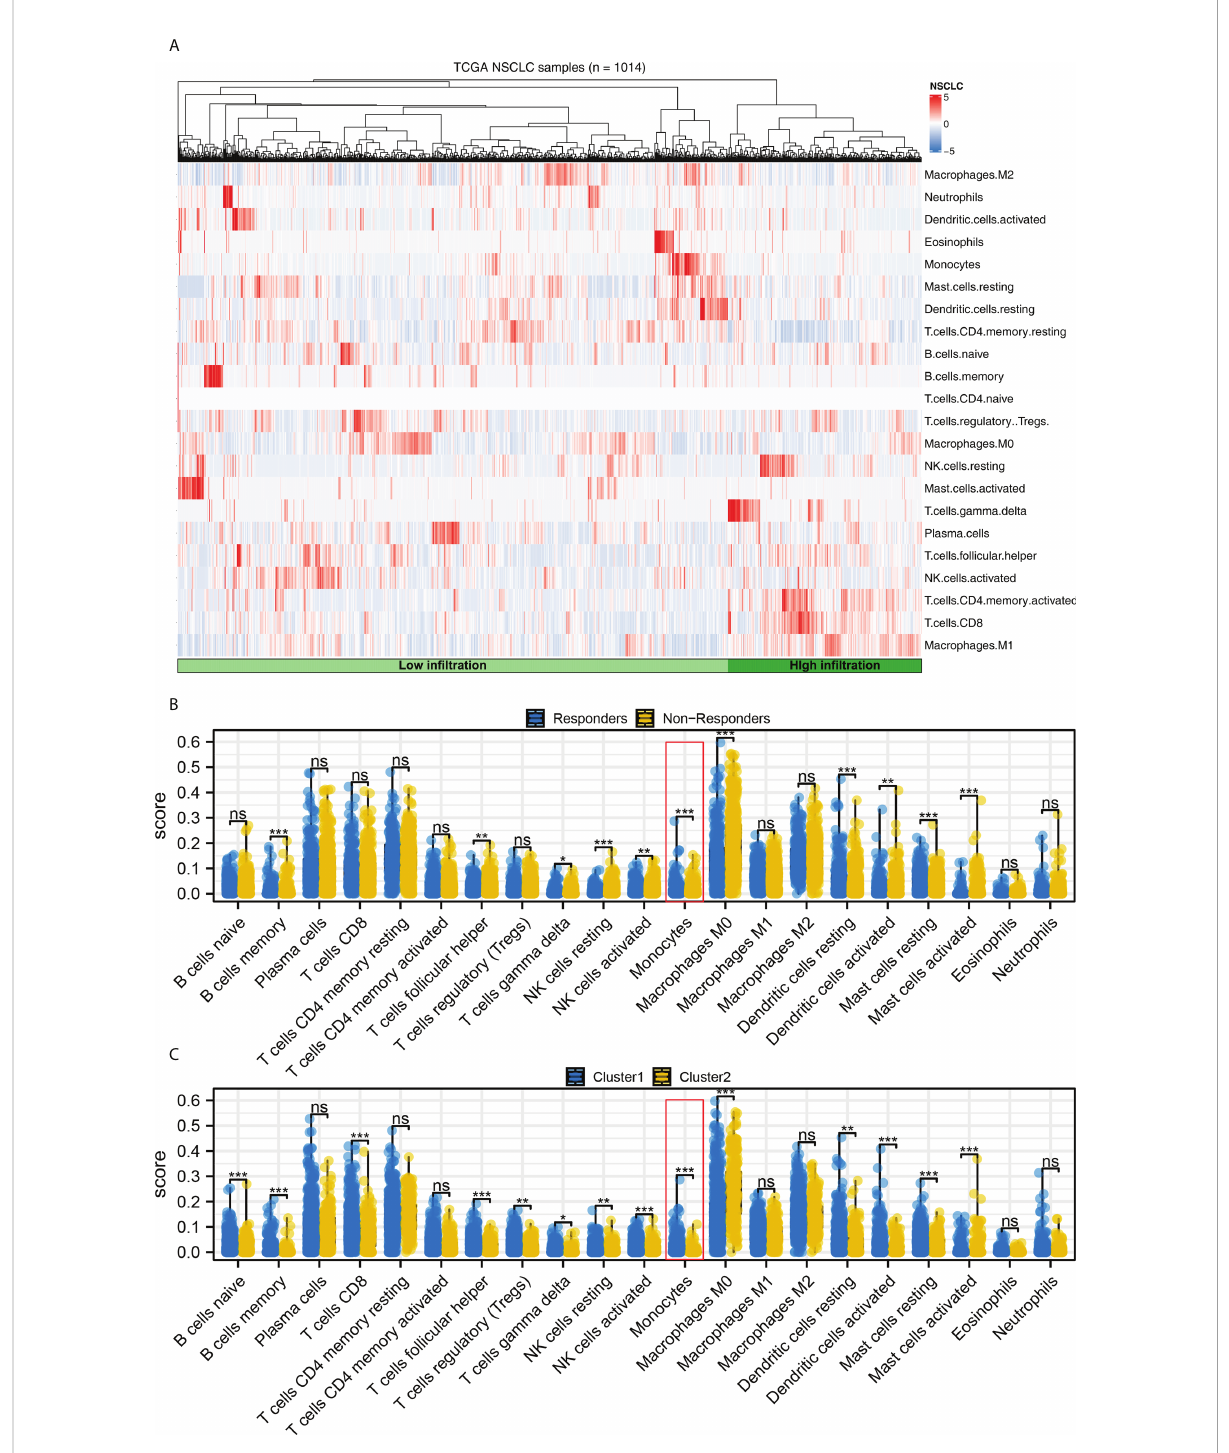
FIGURE 8 Immune in fi ltration. (A) The CIBERSORT algorithm was used to quantify the immune cell in fi ltration; (B) The immune cell in fi ltration level in immunotherapy responders and non-responders, ns = P > 0.05, * = P < 0.05, *** = P < 0.001; (C) The immune cell in fi ltration level in Cluster1 and Cluster2 patients, ns = P > 0.05, * = P < 0.05, ** = P < 0.01, *** = P <